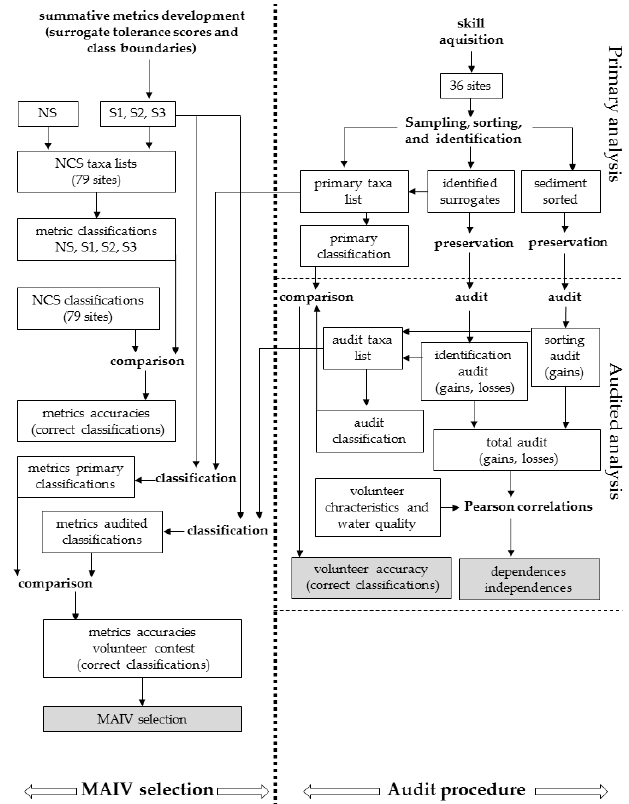
Figure 1. Flow diagram summarizing the methodology adopted for the present study. Inside white boxes are intermediate and final results, being the latter highlighted in grey. Arrows indicated the sequence of the procedures. Metric of Aquatic Invertebrates for Volunteers (MAIV), National Classification System (NCS), summative metrics (S1, S2, and S3), nonsummative metric (NS). Water 2020 , 12 , 654